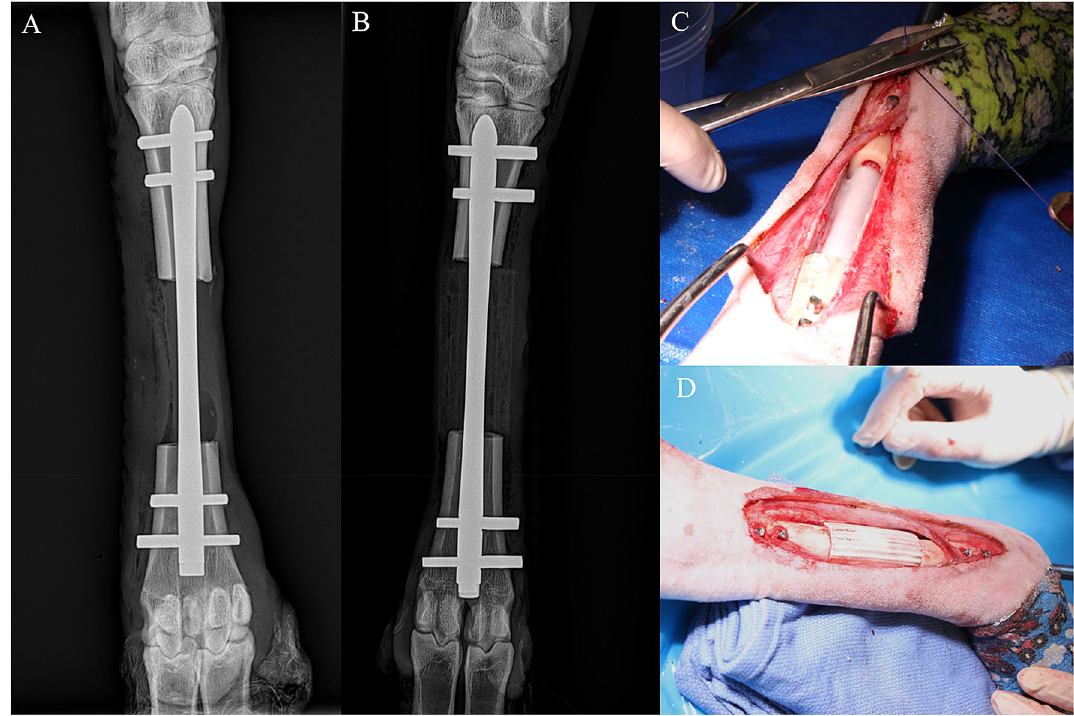
Figure 6. The surgical procedure included a 5 cm ostectomy repaired with an intramedullary nail. The ostectomy gap was filled with either the scaffold and a collagen sponge soaked with rhBMP-2, or a